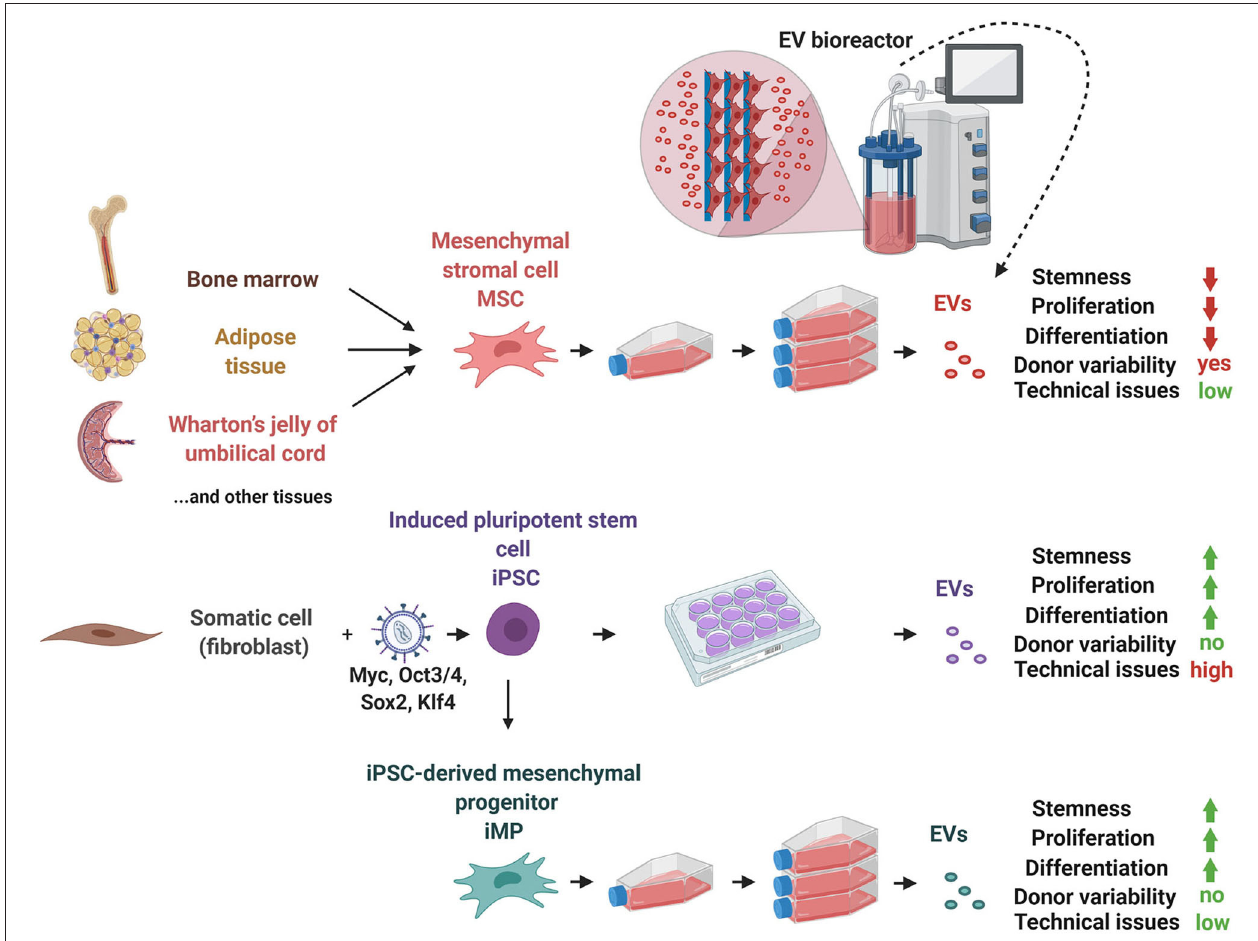
FIGURE 2 | iMP as an alternative cell source of EVs. Although MSCs can easily be maintained in cell culture enabling the production of large volumes of EV-conditioned medium, their proliferation and tri-lineage differentiation capacity declines during prolonged expansion and they are affected by donor variability. Induced pluripotent stem cells (iPSC) that derive from a somatic cell that underwent reprogramming with Myc-Oct3/4-Sox2-Klf4-expressing lentivirus represent an alternative cell source, with unlimited proliferation and differentiation potential that can overcome the donor variability issue. However, these benefits are surpassed by the technical issues related to iPSC maintenance and expansion in culture, as they require expensive media supplements, meticulous day-to-day inspections and handling, which make iPSC expansion in order to increase iPSC-EVs yield quite a challenging and expensive task. Alternatively, iPSC could be subjected